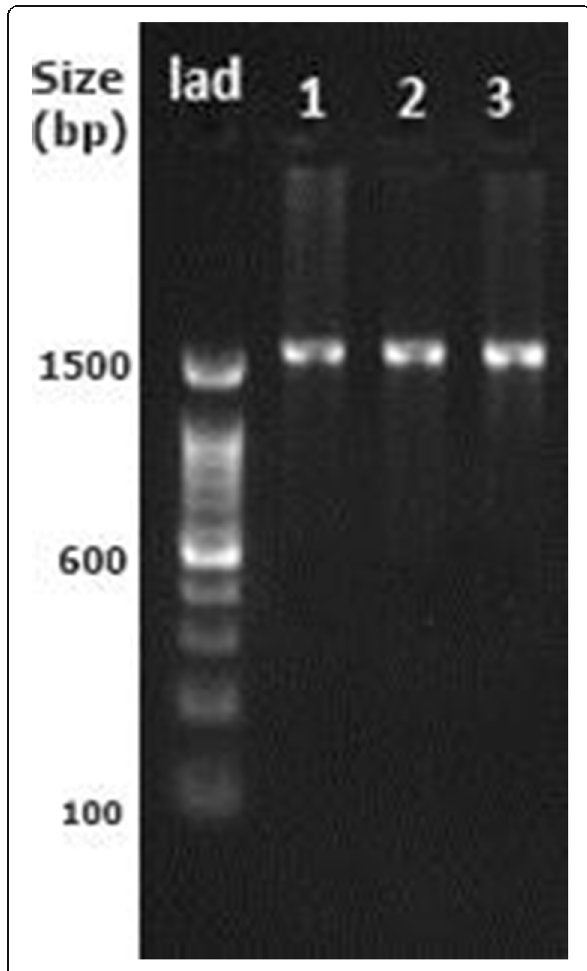
Fig. 3 PCR amplified product of 16S rDNA of bacterial isolates. (Lad: molecular size marker 100 bp; lane 1: isolate HB6J2; lane 2: HB8P1; lane 3: